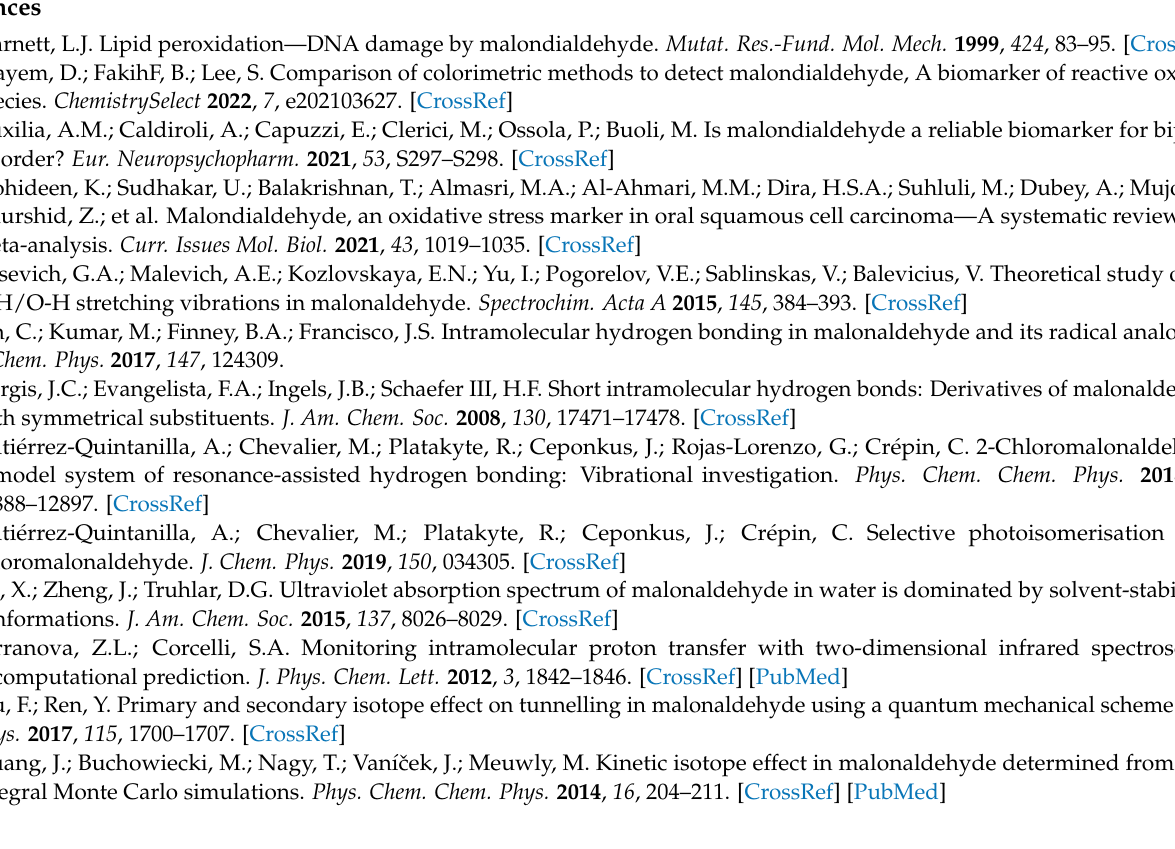
10.3390/molecules27186091/s1, Figure S1: MEP maps of TrX 3 . Color ranges are: red, greater than 0.02; yellow, between 0.02 and 0; green, between − 0.02 and 0; blue, less than − 0.02. All are in a.u., Figure S2: NCI diagram of binary complex formed by the hydroxyl O with TrX 3 . Blue, green, and red areas represent strong attraction, weak attraction, and strong repulsion, respectively. Diagrams are drawn by the Multiwfn and the VMD programs, Figure S3: NCI diagram of binary complex of MDA formed by the carbonyl O with TrX 3 . Blue, green, and red areas represent strong attraction, weak attraction, and strong repulsion, respectively, Figure S4: NCI diagram of π - π structures formed by the carbon center of MDA with TrX 3 . Blue, green, and red areas represent strong attraction, weak attraction, and strong repulsion, respectively, Figure S5: Structure of MDA-BBr 3 -c at a B ··· C distance of 1.8 Å, Figure S6: The energy curve of MDA-BBr 3 -c by changing the B ··· C distance from 1.5 to 3.5 Å, Table S1: Charge transfer (CT, e) in the complexes, Table S2: Electrostatic (E ele ), exchange (E ex ), repulsion (E rep ), polarization (E pol ), and dispersion energies (E disp ) as well as the total interaction energy ( ∆ E total ) of triel bond in the binary complexes. All are in